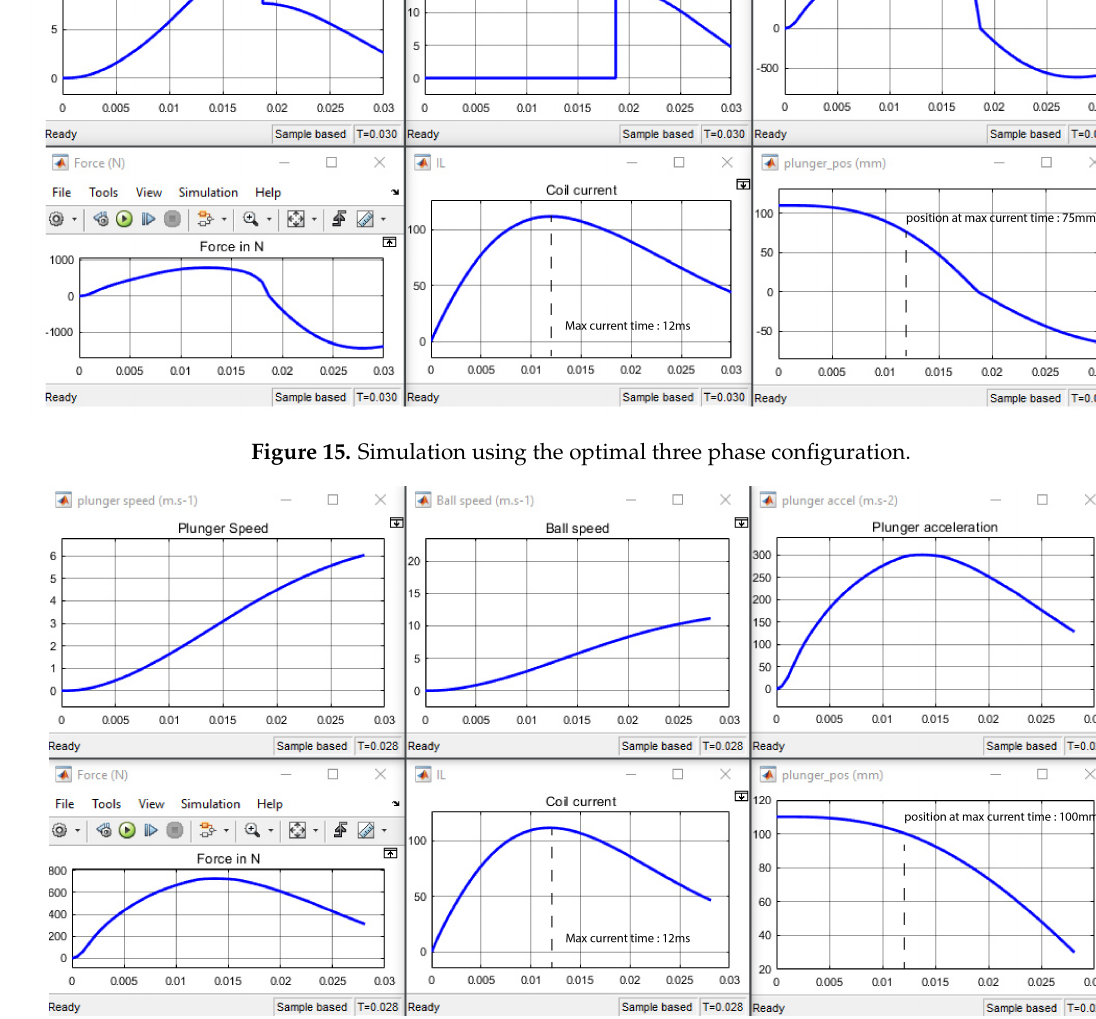
Figure 16. Simulation using the Tech United [5] one phase